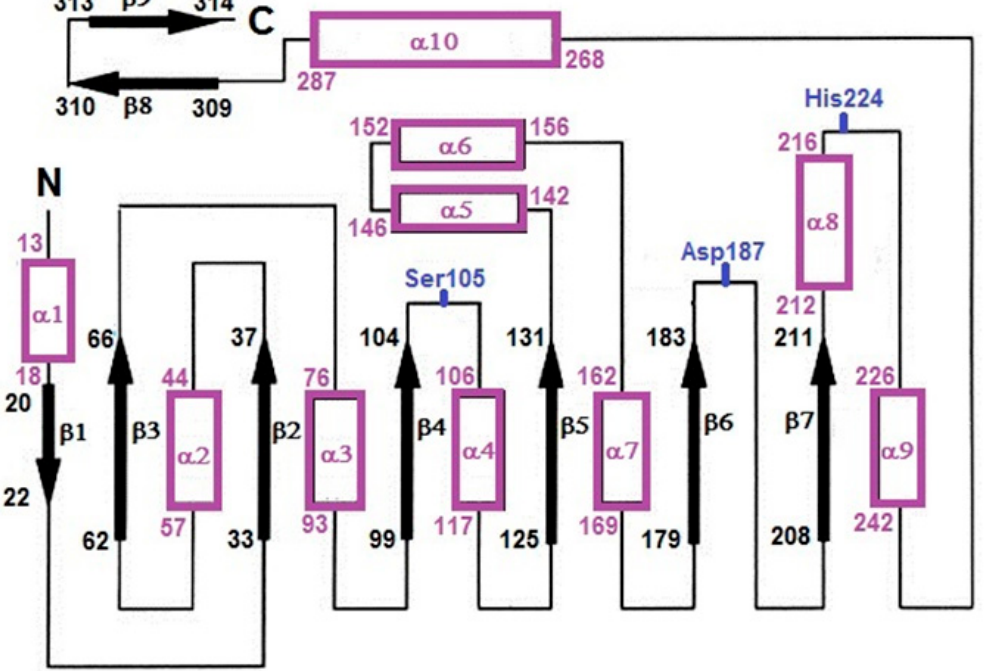
Figure 1. Secondary structure diagram of the Candida antarctica (CAL-B) molecule [27].